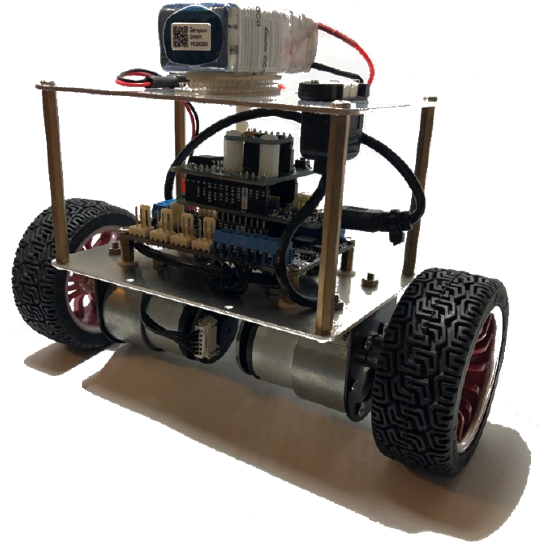
Figure 7. MS robot.